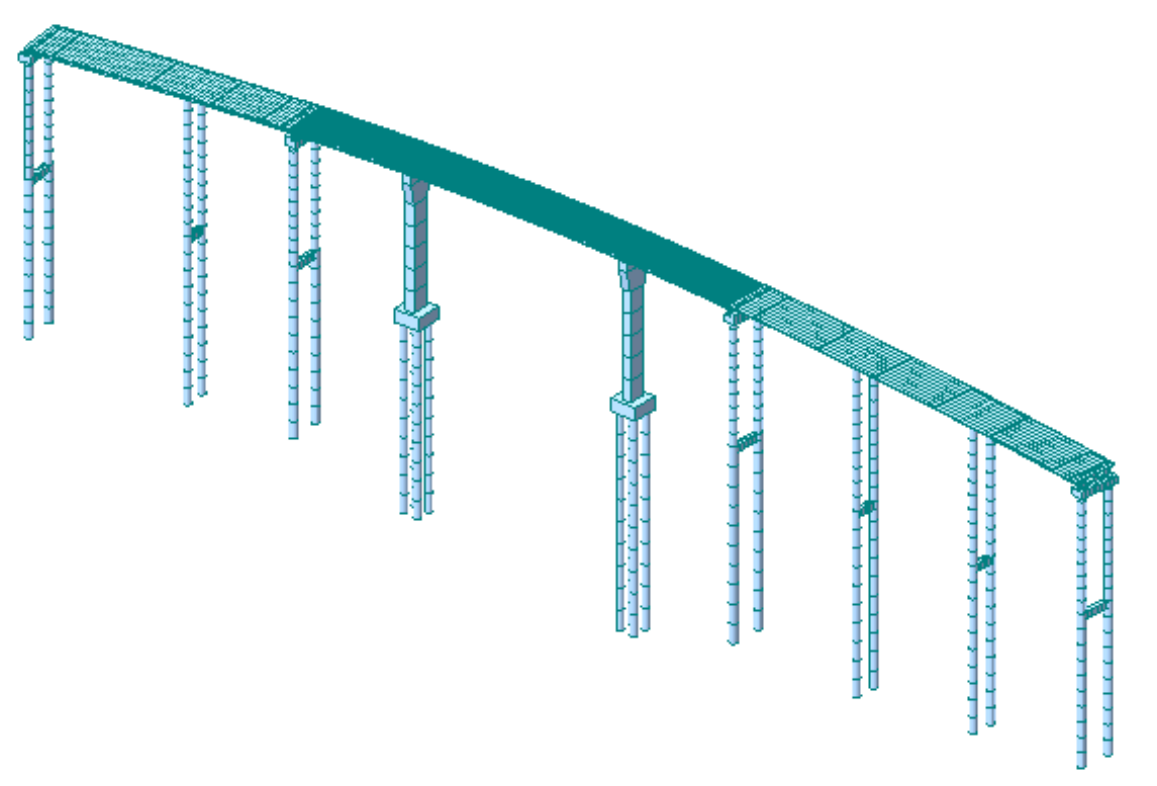
Figure 12. Three-dimensional Midas model.